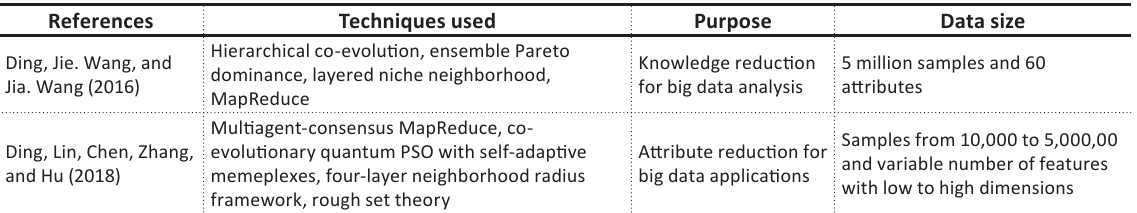
Source: Developed by the